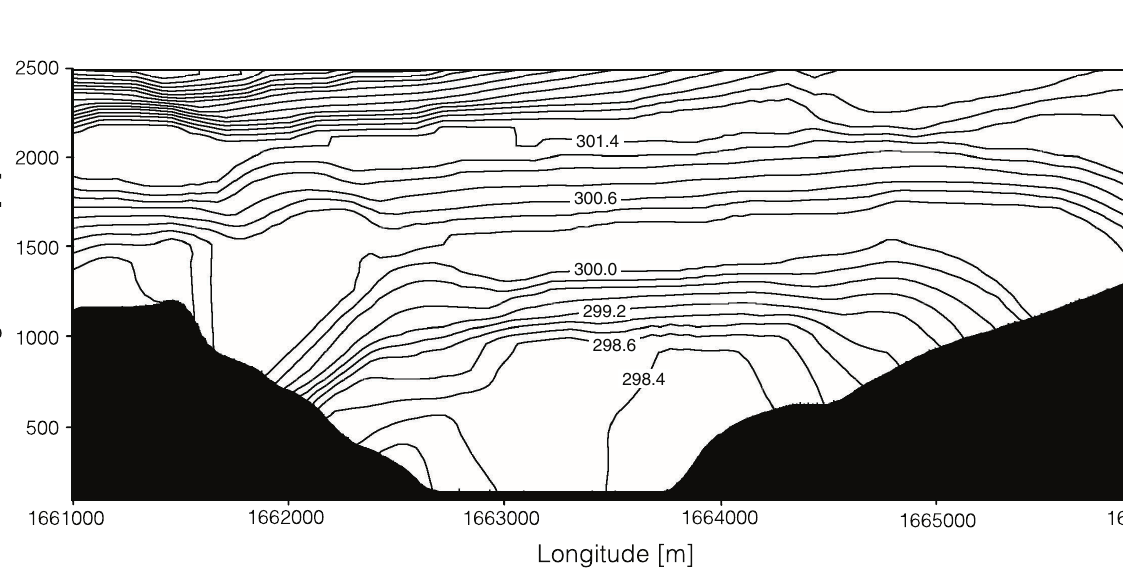
over a valley cross-section (over Besenello fi g. 5) from v